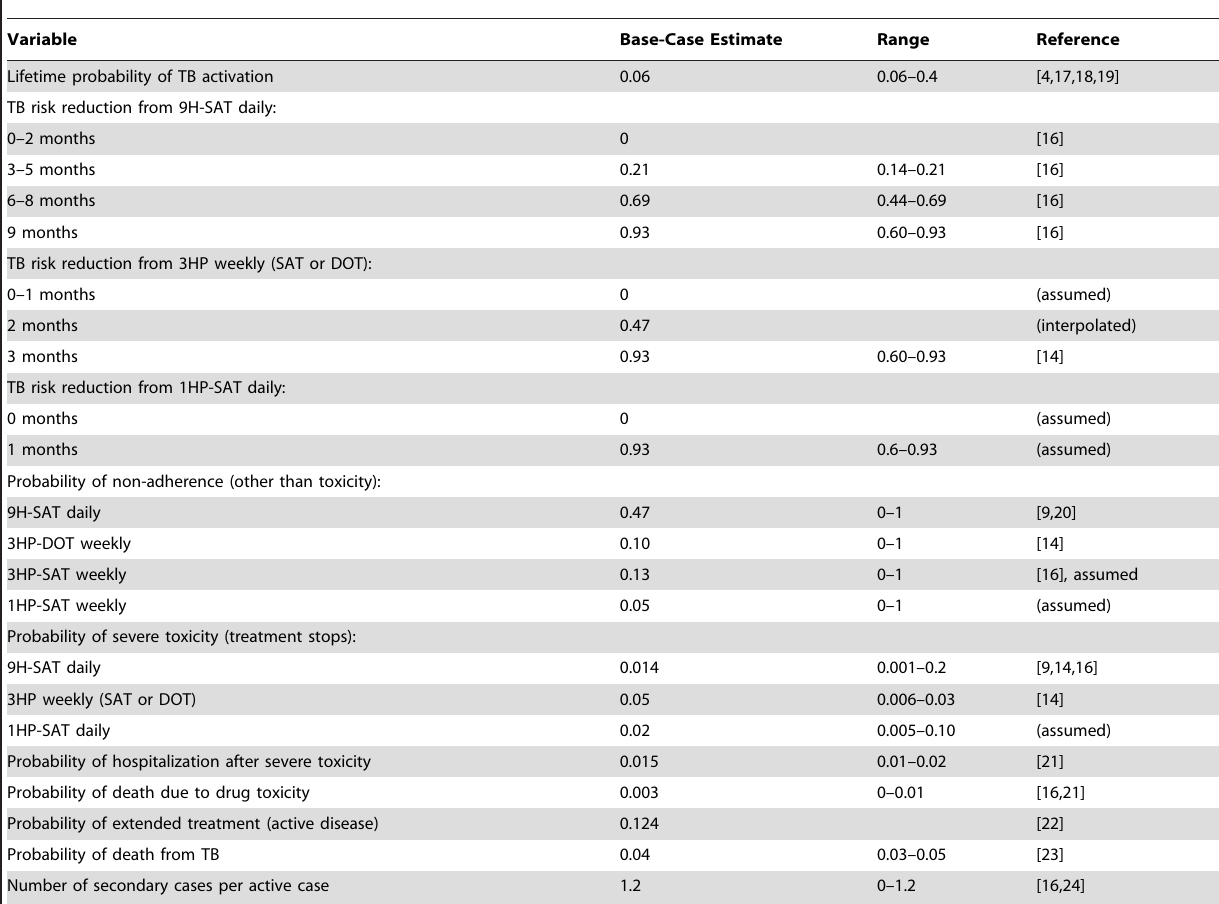
Table 1. Base-case parameters and probabilities used in the model.